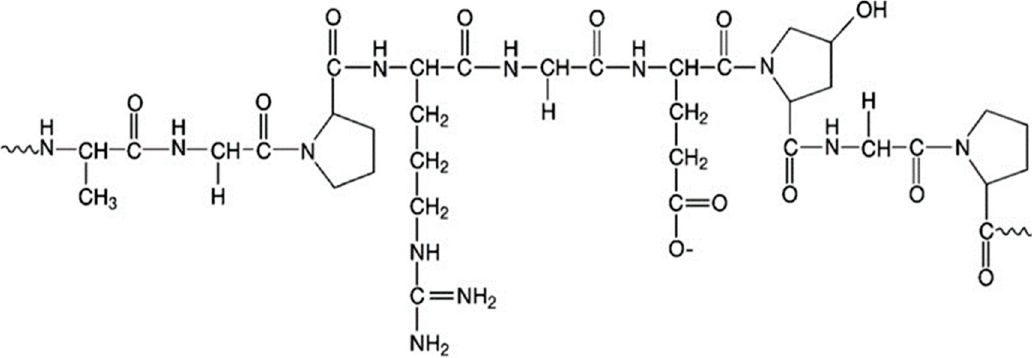
Figure 1. Basic chemical structure of gelatin.